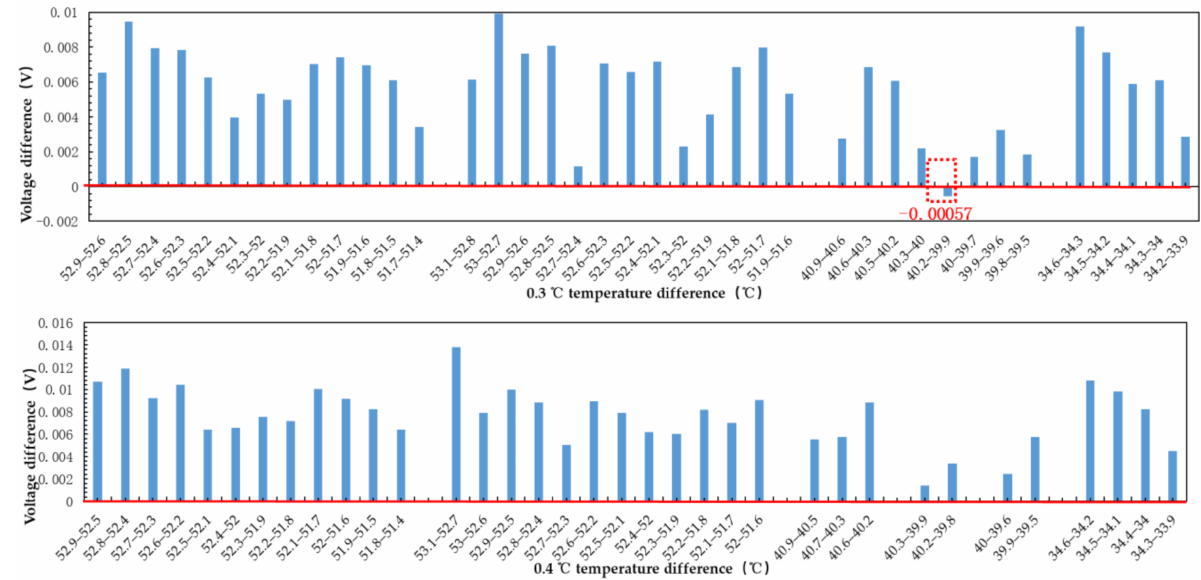
Figure 13. Mean voltage value of water at 33–55 ◦ C measured by microwave radiometer.